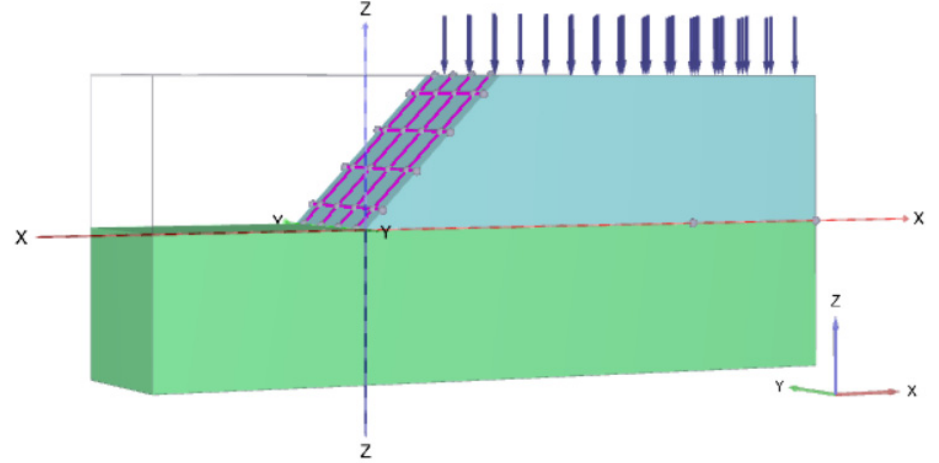
Figure 23. The 1:1 model of filled-slope reinforced by frame with prestressed anchor-plates.